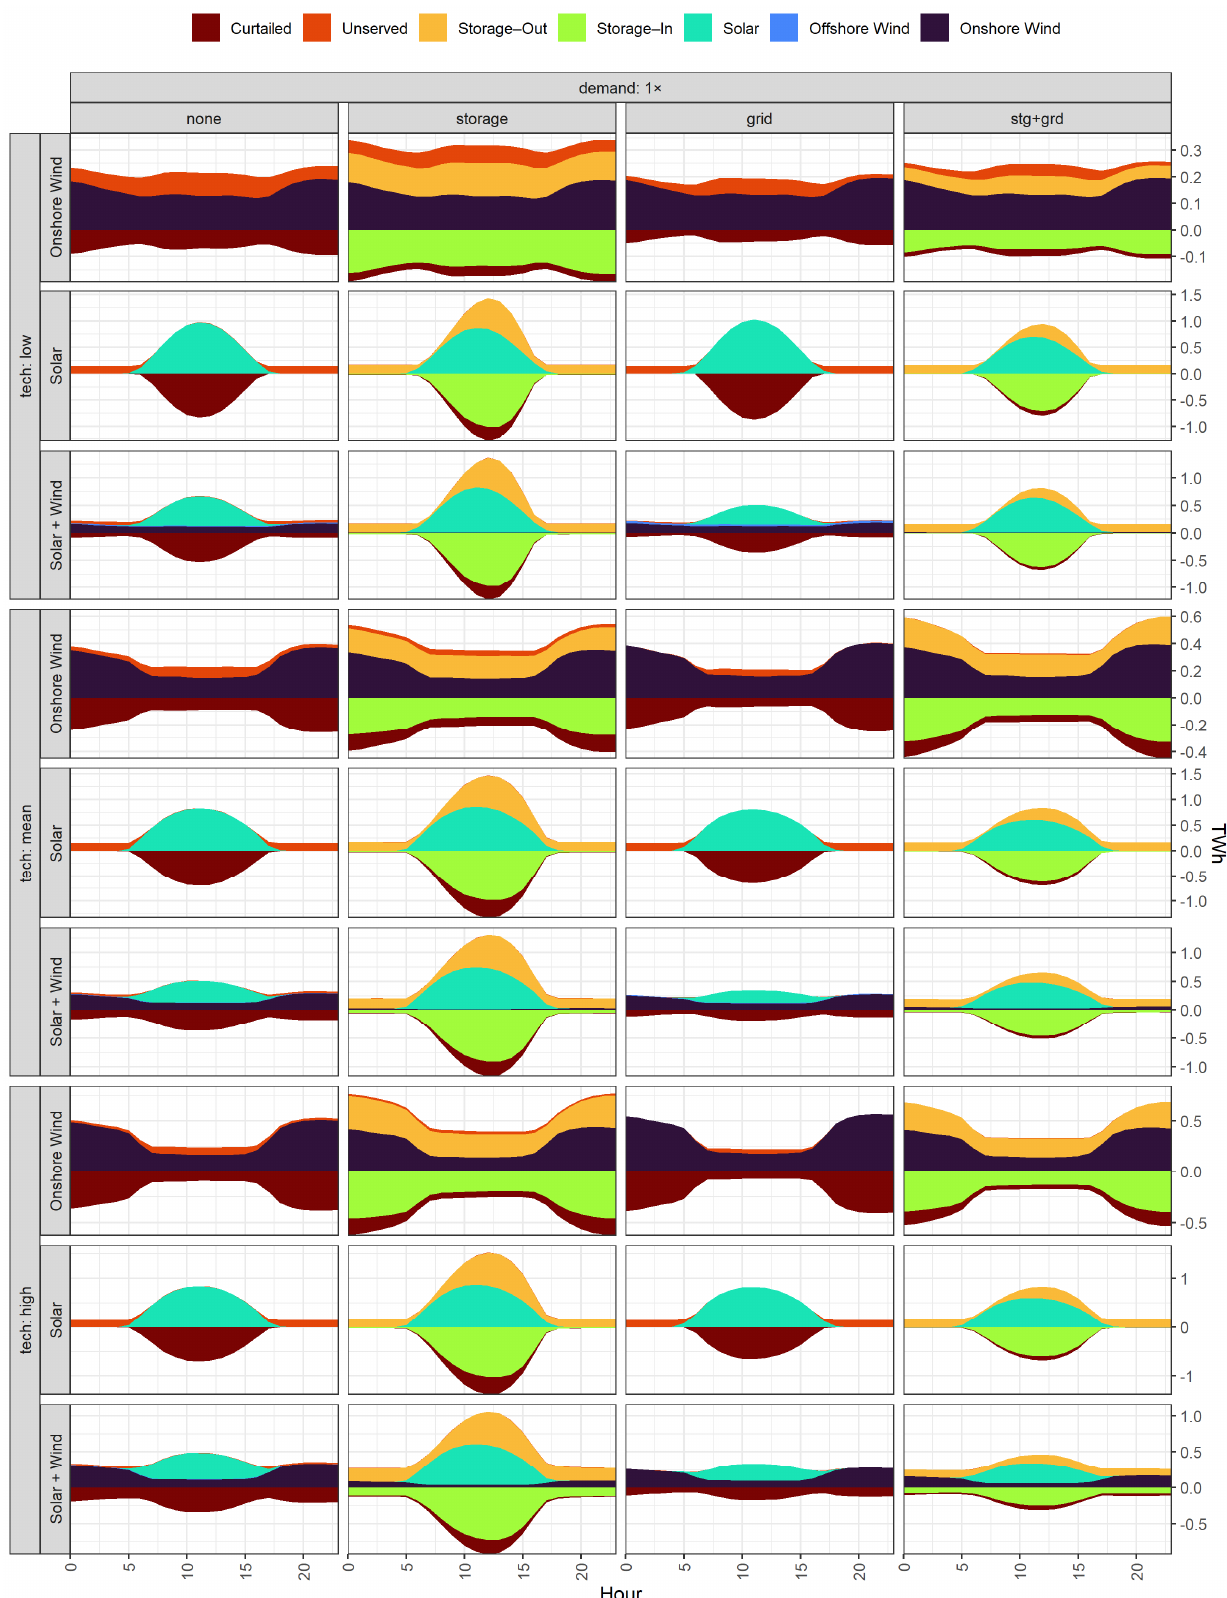
Figure A16. Annual average generation profile by hours and scenario (1 × group). Note: The comparative figures summarise intraday generation profiles of power system design with alternative sets of generation and balancing options, as well as system failures to serve the load (‘unserved’) and inefficiencies (‘curtailed’).